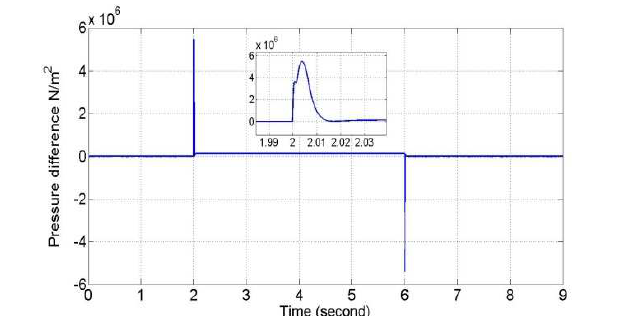
under (cid:157) £ (cid:159) = (cid:160). £